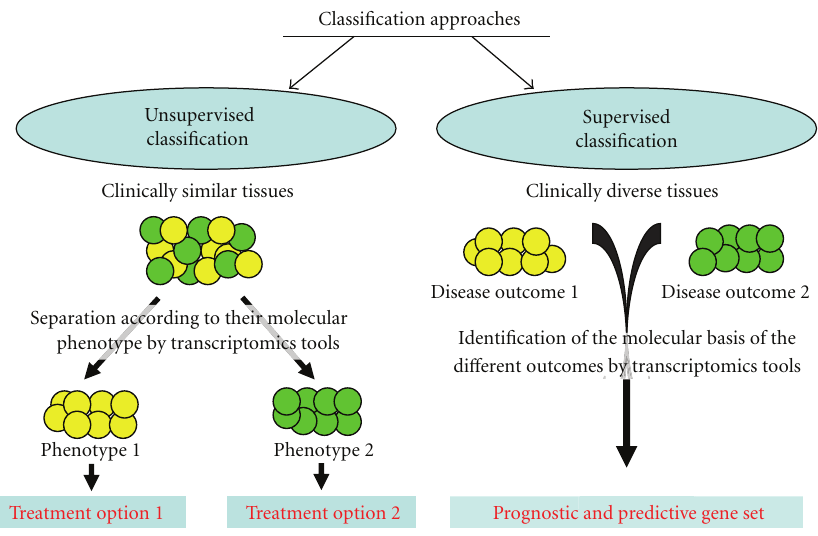
Figure 5: Two major approaches for the identification of disease-relevant gene expression profiles are supervised and unsupervised clas- sification. Unsupervised classification is used to identify di ff erent molecular mechanisms in tissues from patients with clinically similar disease phenotypes. Clustering of these tissues according to their molecular phenotype may lead to the identification of di ff erent molecular phenotypes behind the identical clinical behaviour. This knowledge may finally lead to diverse therapy protocols of these molecular subtypes. In contrast, during supervised clustering, molecular mechanisms behind di ff erent disease outcome or phenotypes are analyzed. Two tissue groups with clinical di ff erences are therefore compared, and the di ff erences in gene expression are thought to be relevant for the distinct clinical behaviour. The resulting set of genes may also serve prognostic markers for the prospective classification tissue samples.